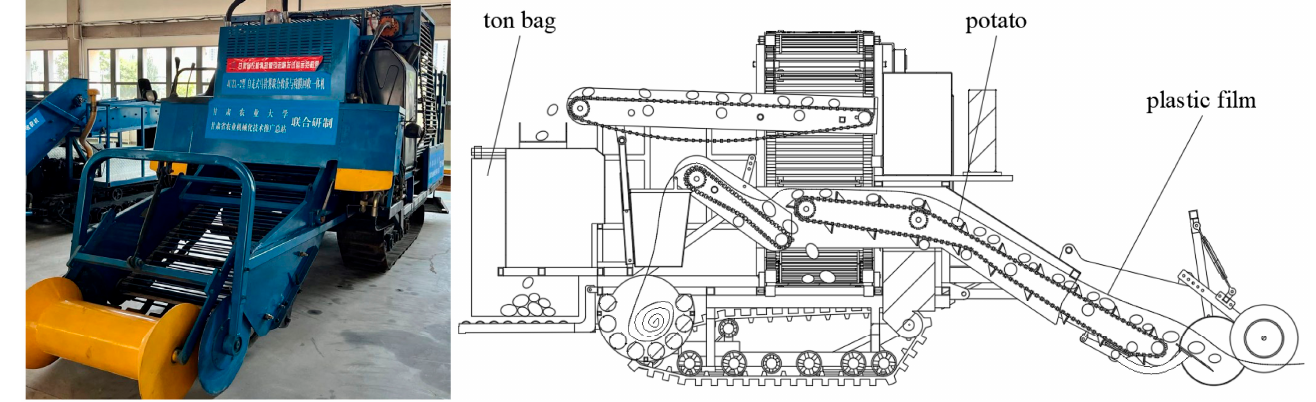
Figure 1. Photograph and schematic of operation of the self-propelled machine for combined potato harvesting and residual plastic film retrieval.